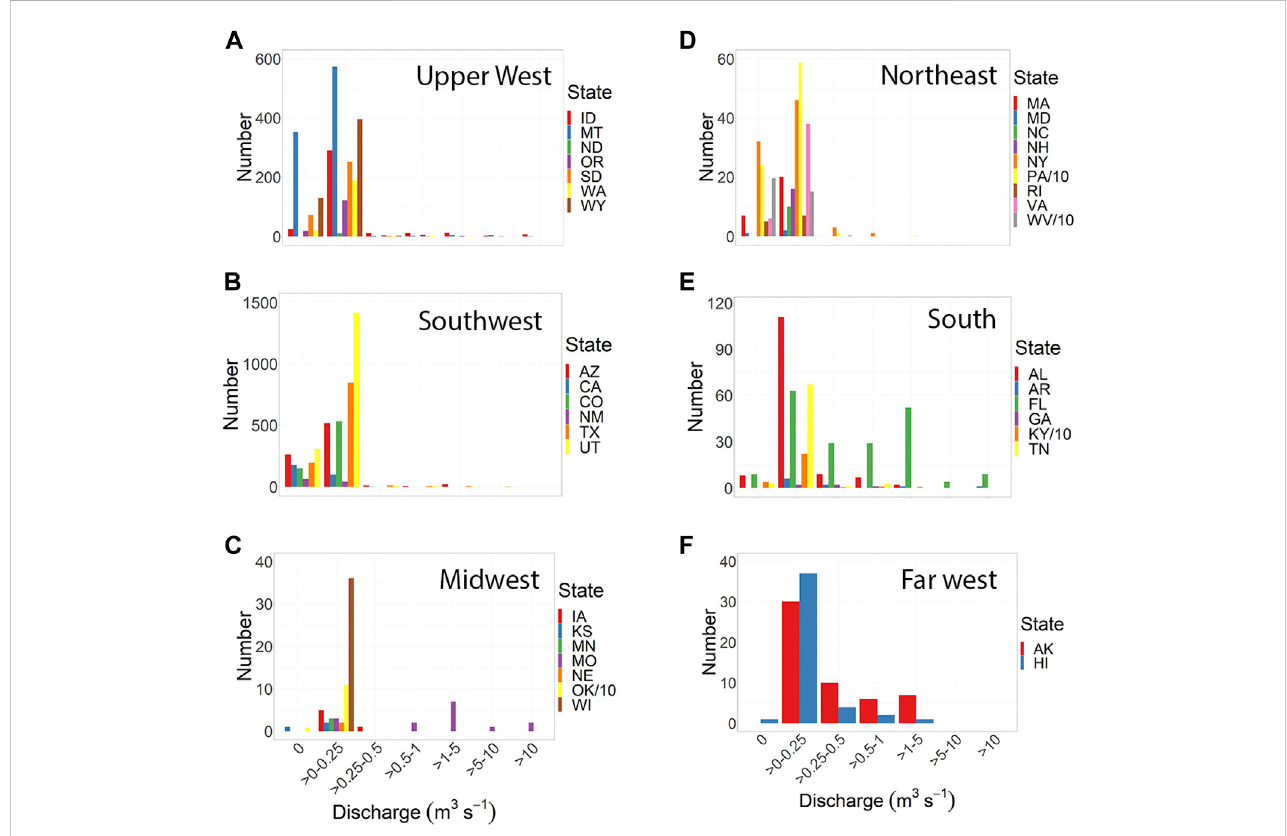
FIGURE 2 Sizefrequencydistributionsofsprings rangingfromnot fl owingtoover100cfsinthe42of50USstates forwhichthereweredischargedata intheNWIS database. The states were somewhat arbitrarily divided by region: the upper west (A) , southwest (B) , midwest (C) , northeast (D) , south (E) , and Alaska and Hawaii (F)